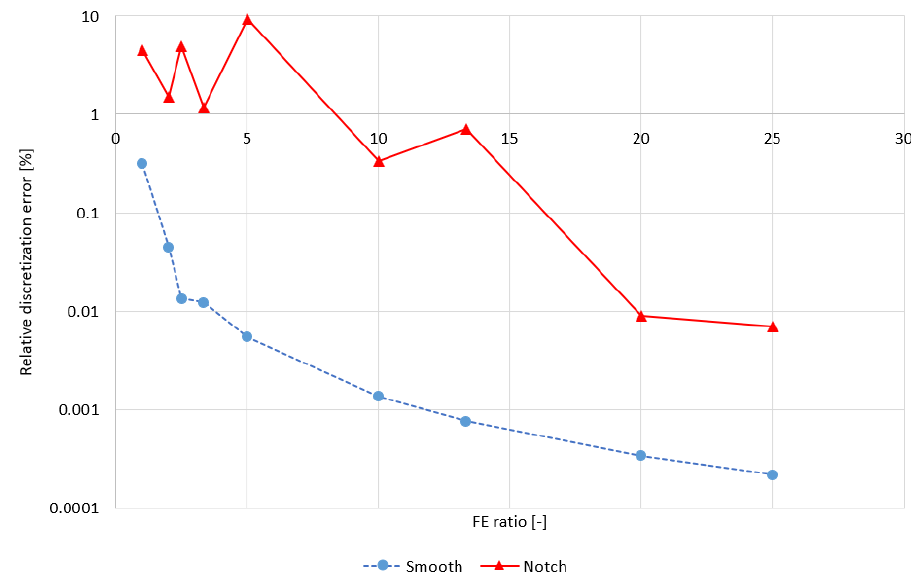
Figure 4. Relative discretization error behaviour for smooth shaft and notch–semilogarithmic axis are